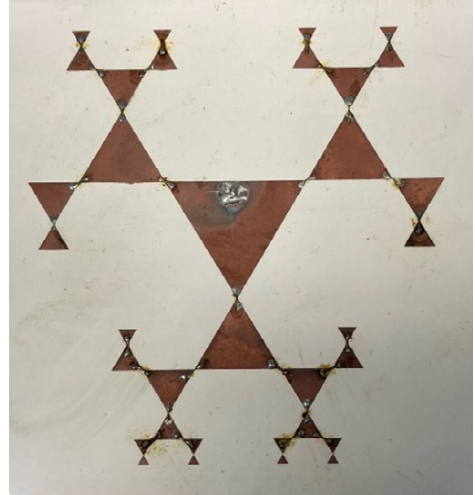
Figure 4. Energy-harvesting antenna